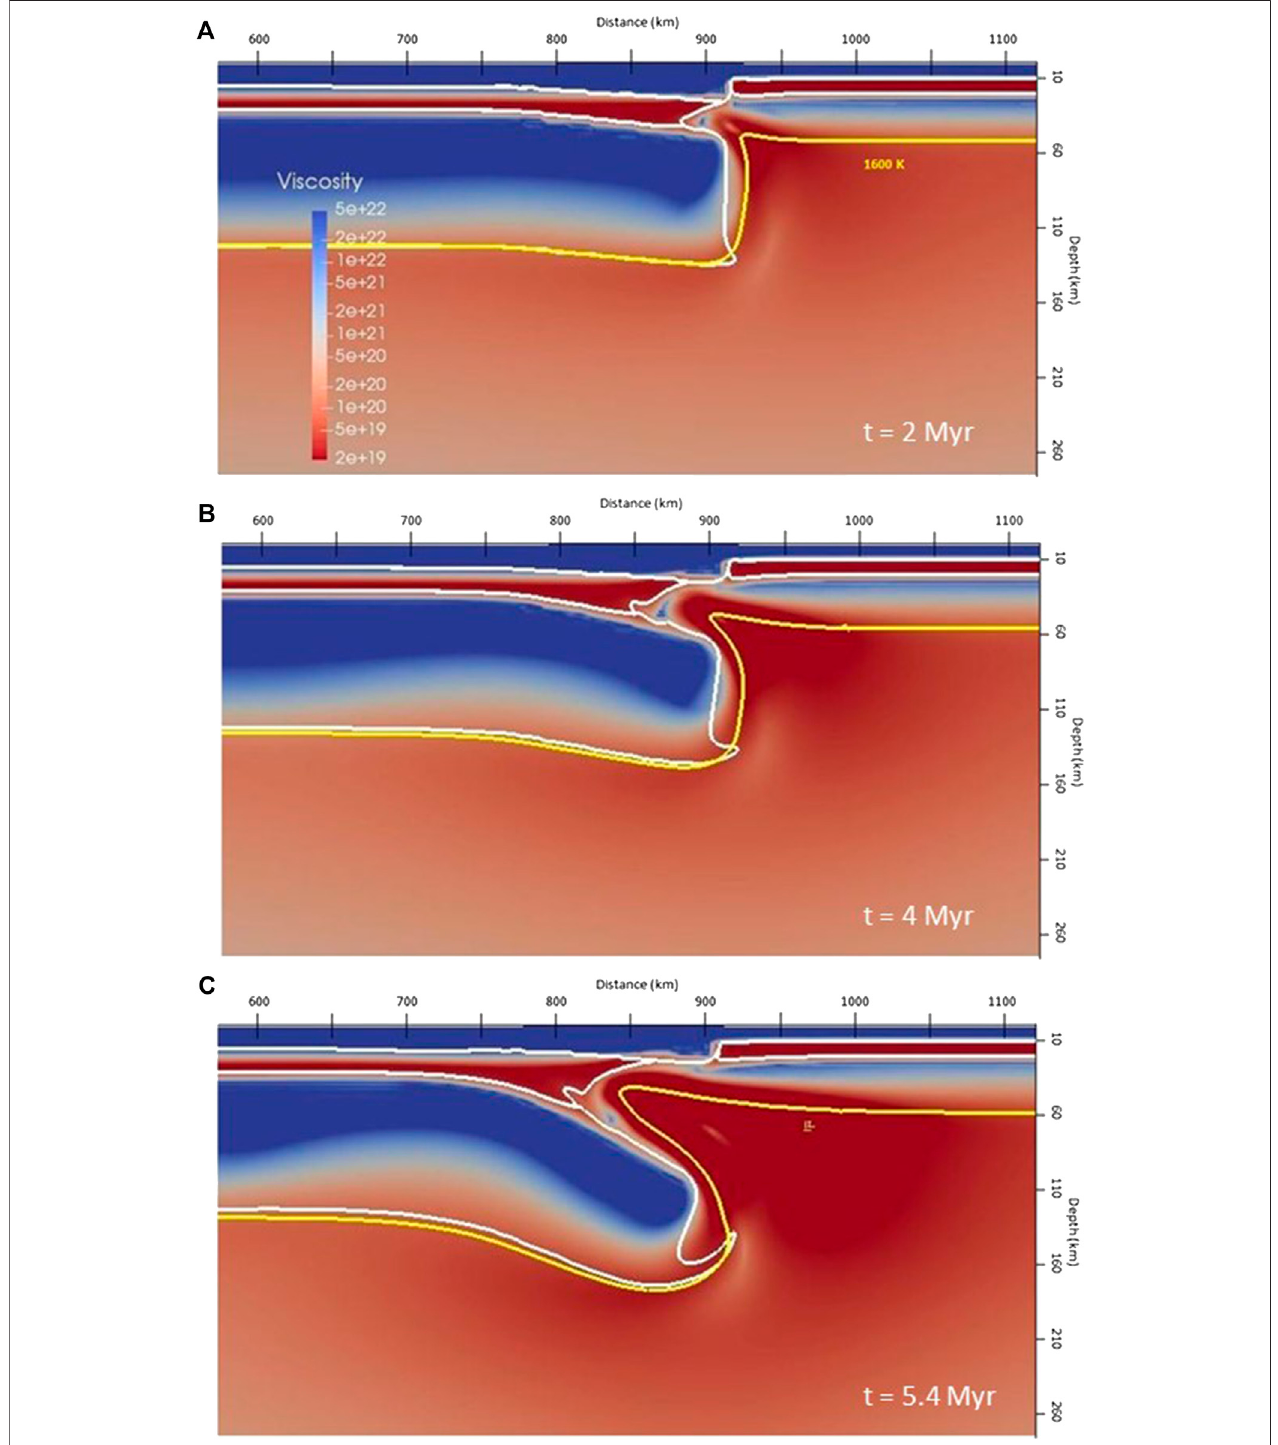
FIGURE 6 | Distribution of viscosity (logarithmic scale plot; Pa s units) and location of the 1,600 K isotherm at different times (A) 2, (B) 4, and (C) 5.4 Myr of the Reference Model.